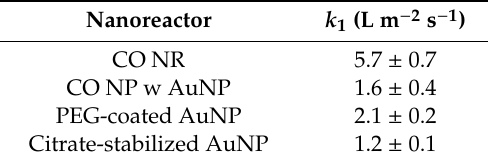
Table 2. Reaction kinetics of castor oil nanoreactors (CO NR) compared to gold nanoparticles added to preformed castor oil nanoparticles (CO NP w AuNP), PEG-coated gold nanoparticles (PEG-coated AuNP) and citrate-stabilized gold nanoparticles (citrate-stabilized AuNP) at equivalent gold concentrations measured at 1.0-M NaBH 4 and 0.1-mM